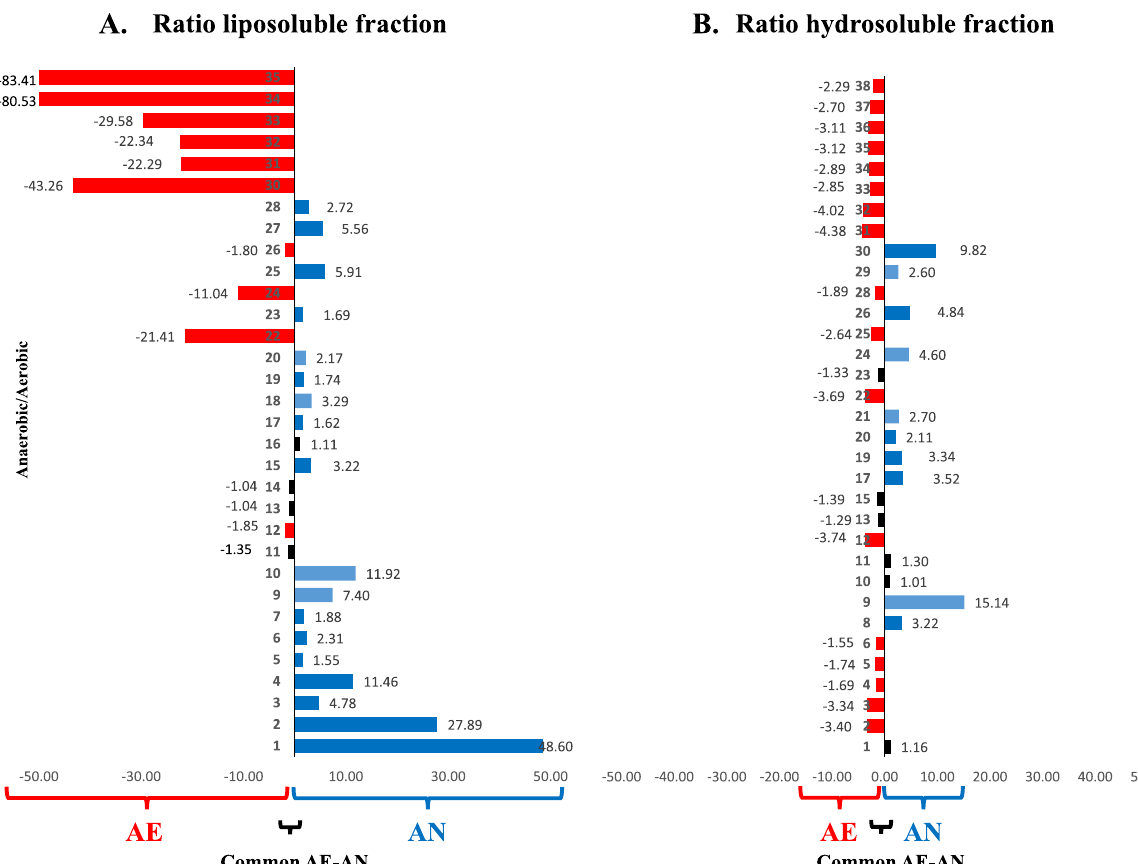
(Fig. 4d) (Additional file 1: Table S1). The amount of proteins with translation regulatory activity was higher in anaerobic mycoplasma (16.7% versus 7.1% in aerobic), while the proteins with structural activity were expressed at higher percentage in the aerobic mycoplasma (14.3% versus 5.6% in anaerobic) (Fig. 4c).